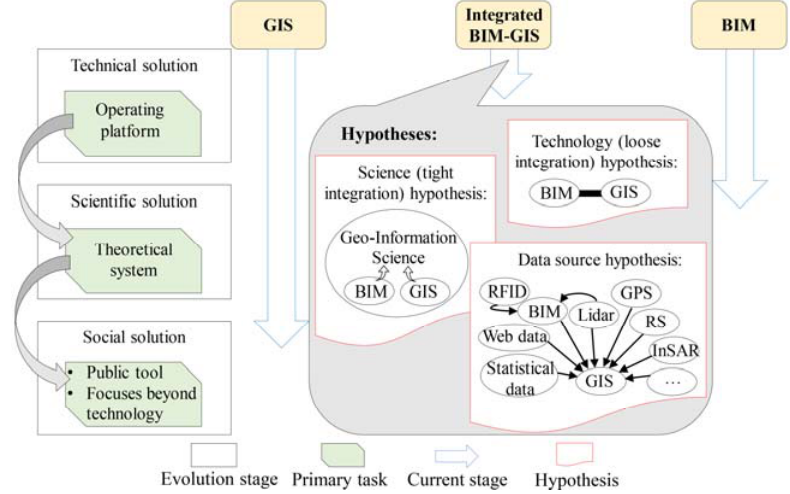
Figure 5. Hypotheses of future development of BIM-GIS integration. Table 5. Contents of three hypotheses of future trends of BIM-GIS integration.